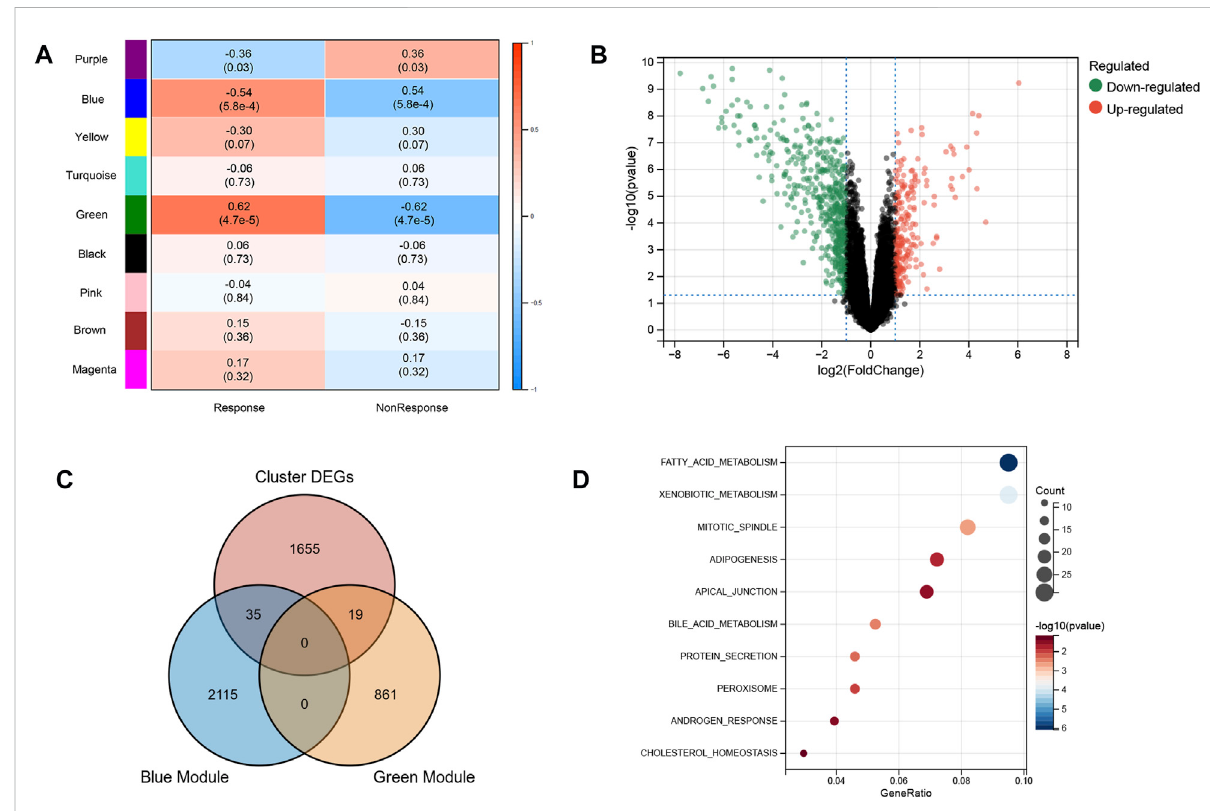
Characteristic of two subtypes. (A) WGCNA module trait relationships in response and non-response groups, which contained the corresponding correlation and p -value. Each colored row on the left represents a gene module (B) Volcano plot ofDEGs between two subtypes. (C) Intersection of DEGs and response-related genes. (D) Biological functions of intersected